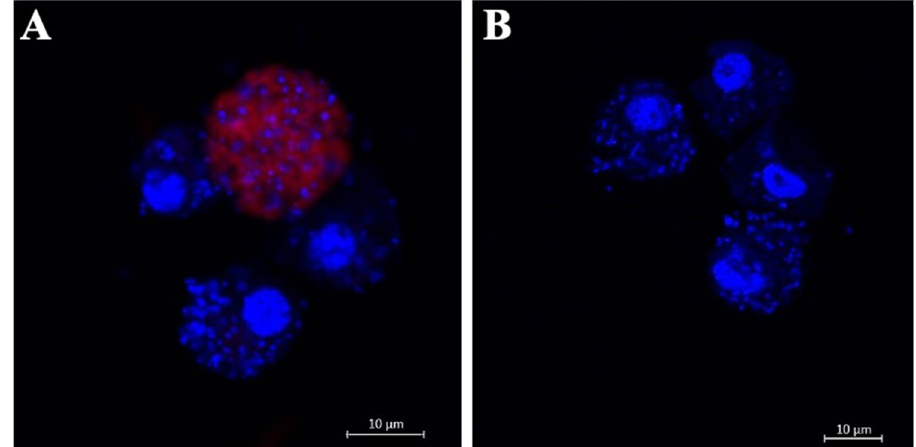
Figure 1. Localization of FANA oligo in S2-wDi cells. Images were acquired using DAPI (blue) and Alexa Fluor 647 (red) filters. ( A ) Cells incubated with 10 µM of a FANA ASO tagged with Alexa Fluor 647. ( B ) Untreated cells. DAPI stained the S2 cells nuclei as well as wDi chromosomes (small blue